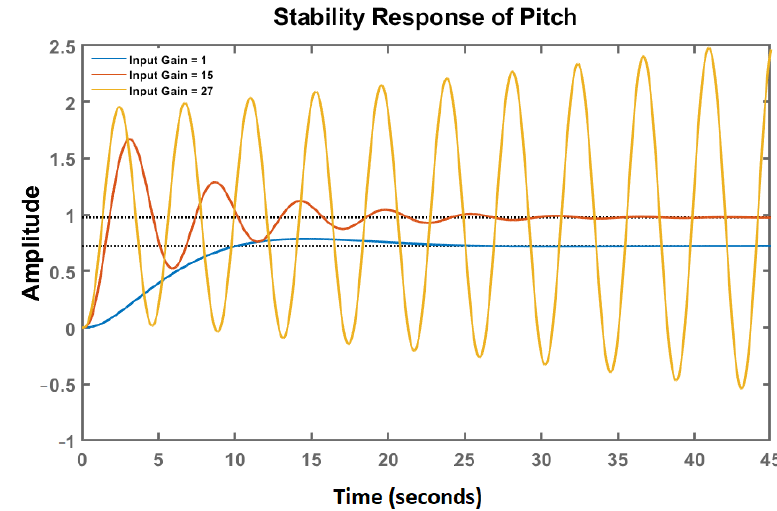
Figure 6. Pitch control system step response with varied gains.